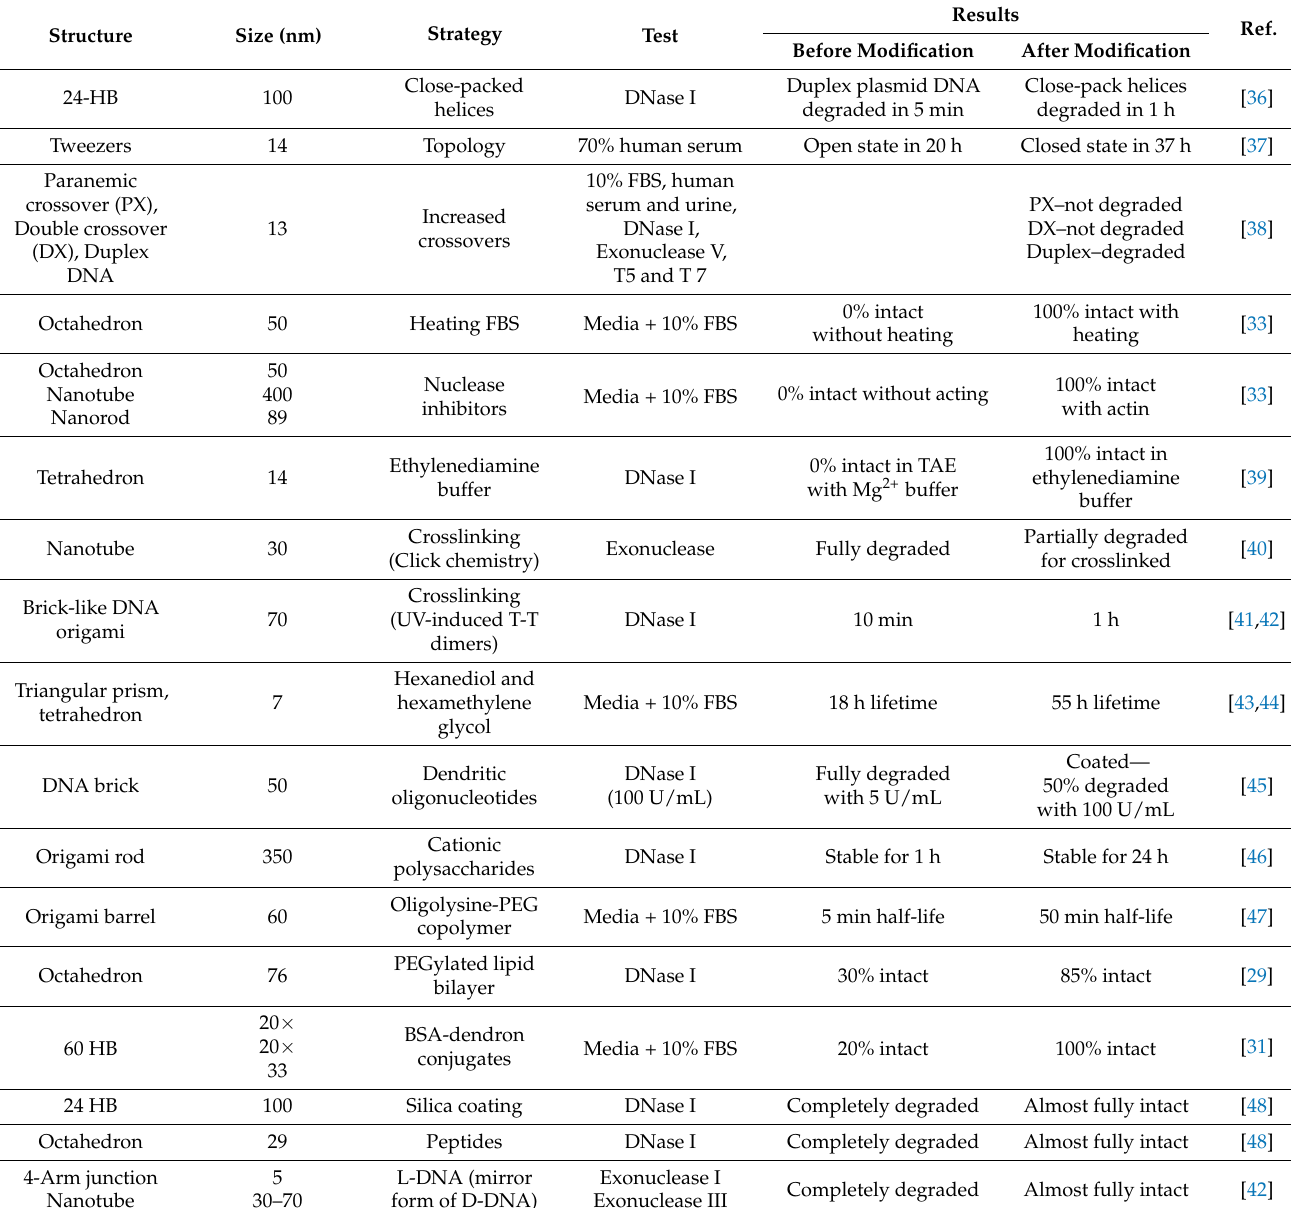
Table 1. Strategies to modulate nuclease resistance in a living